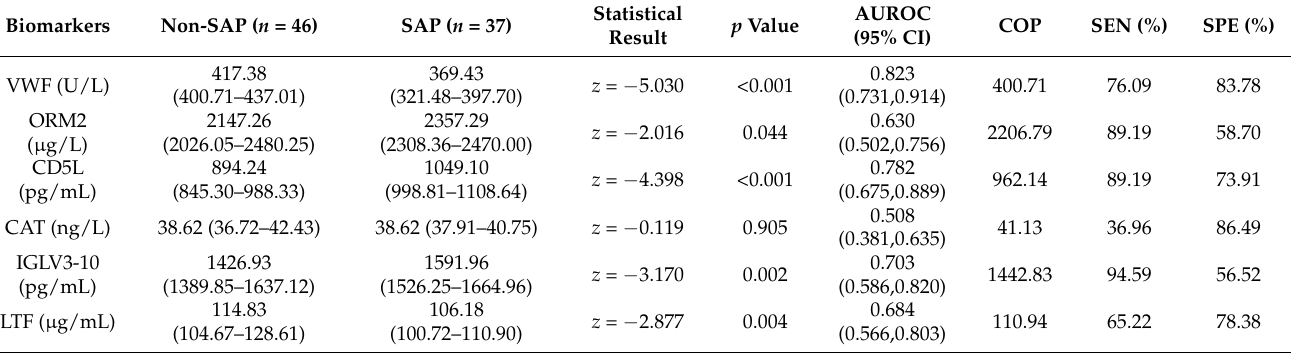
Table 3. Marker levels in patients with severe acute pancreatitis or non-severe acute